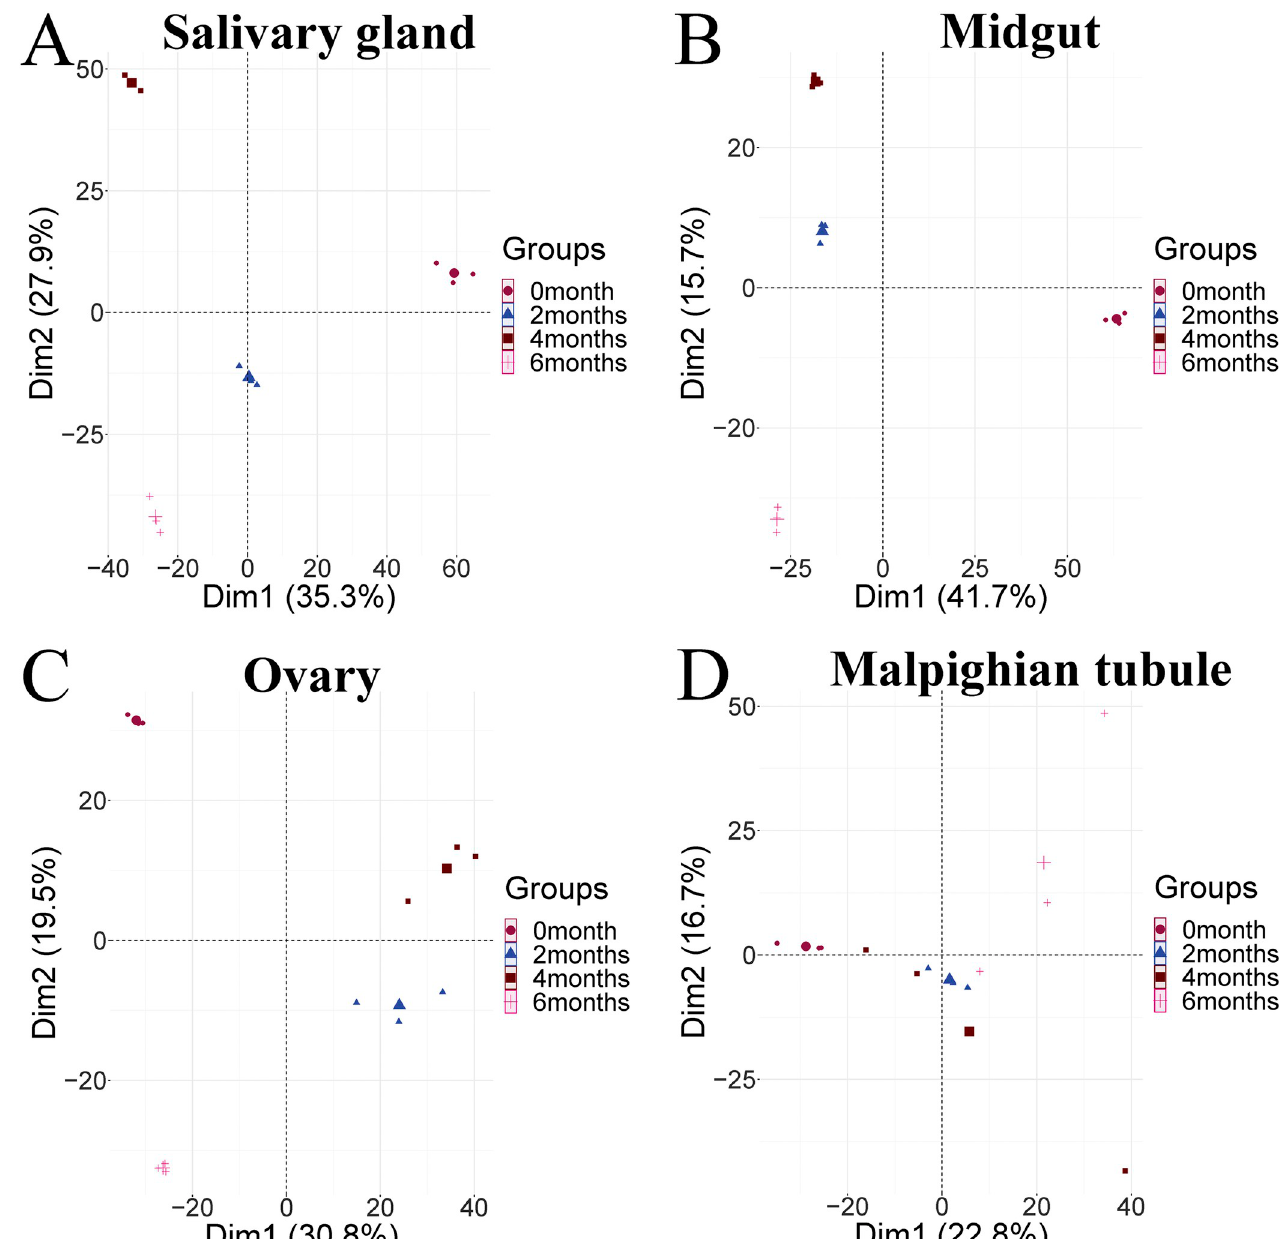
Fig 2. PCA analysis of four tissues in different periods of starvation of female H . longicornis . A. Salivary glands, B. Midguts, C. Ovaries, D. Malpighian tubules.